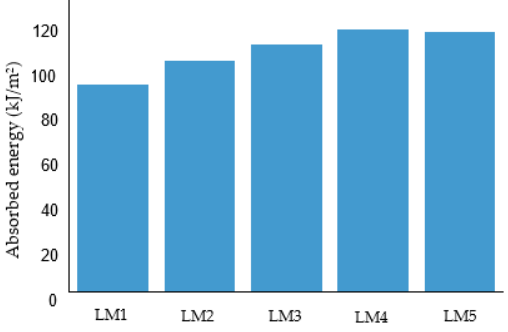
Figure 5. Charpy impact energy of the specimen with different layup sequence.